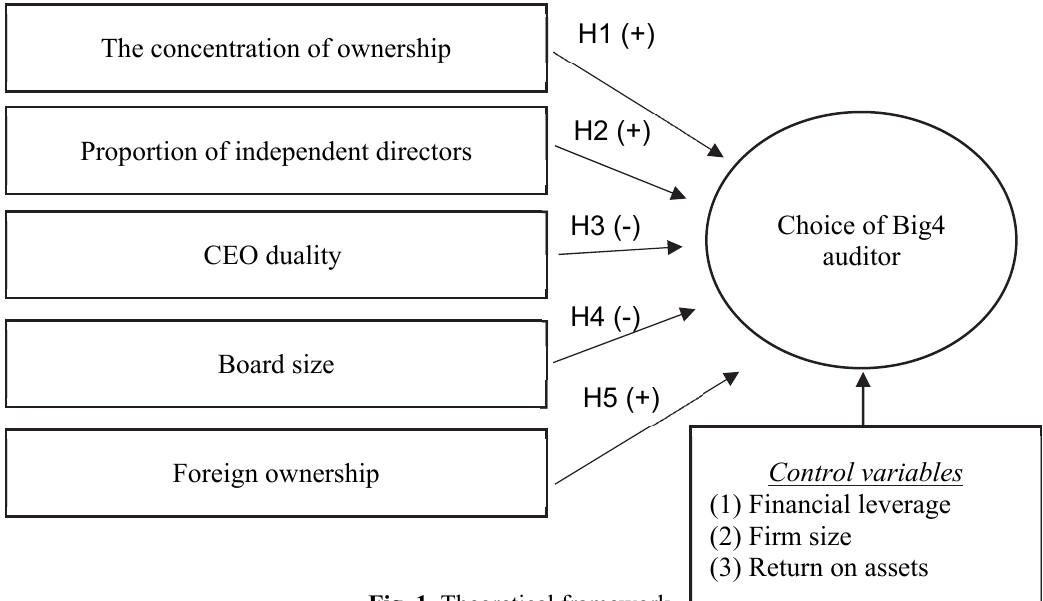
Fig. 1. Theoretical